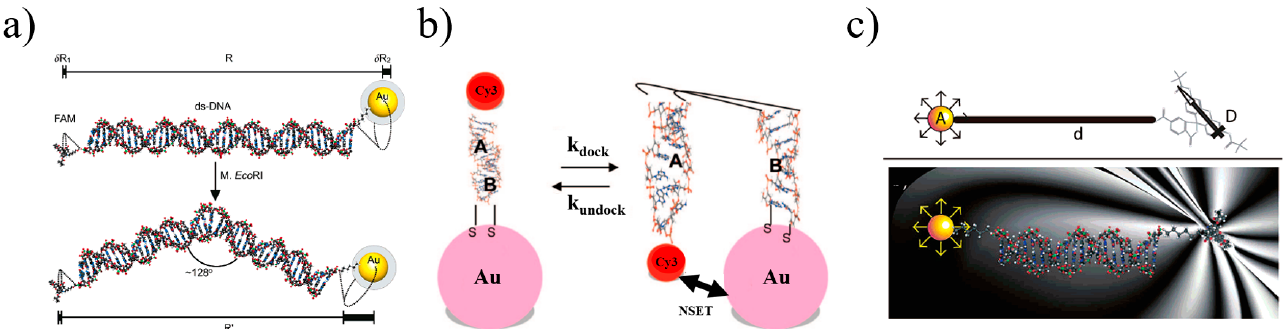
Figure 16. ( a ) Schematic drawing of the NSET system, which consists of gold NPs and fluorophores appended to dsDNA [81]. ( b ) Hairpin ribozyme of the docking and undocking transitions [83]. ( c ) Schematic diagram of a donor-dye–nanometal-acceptor pair separated by dsDNA [84].